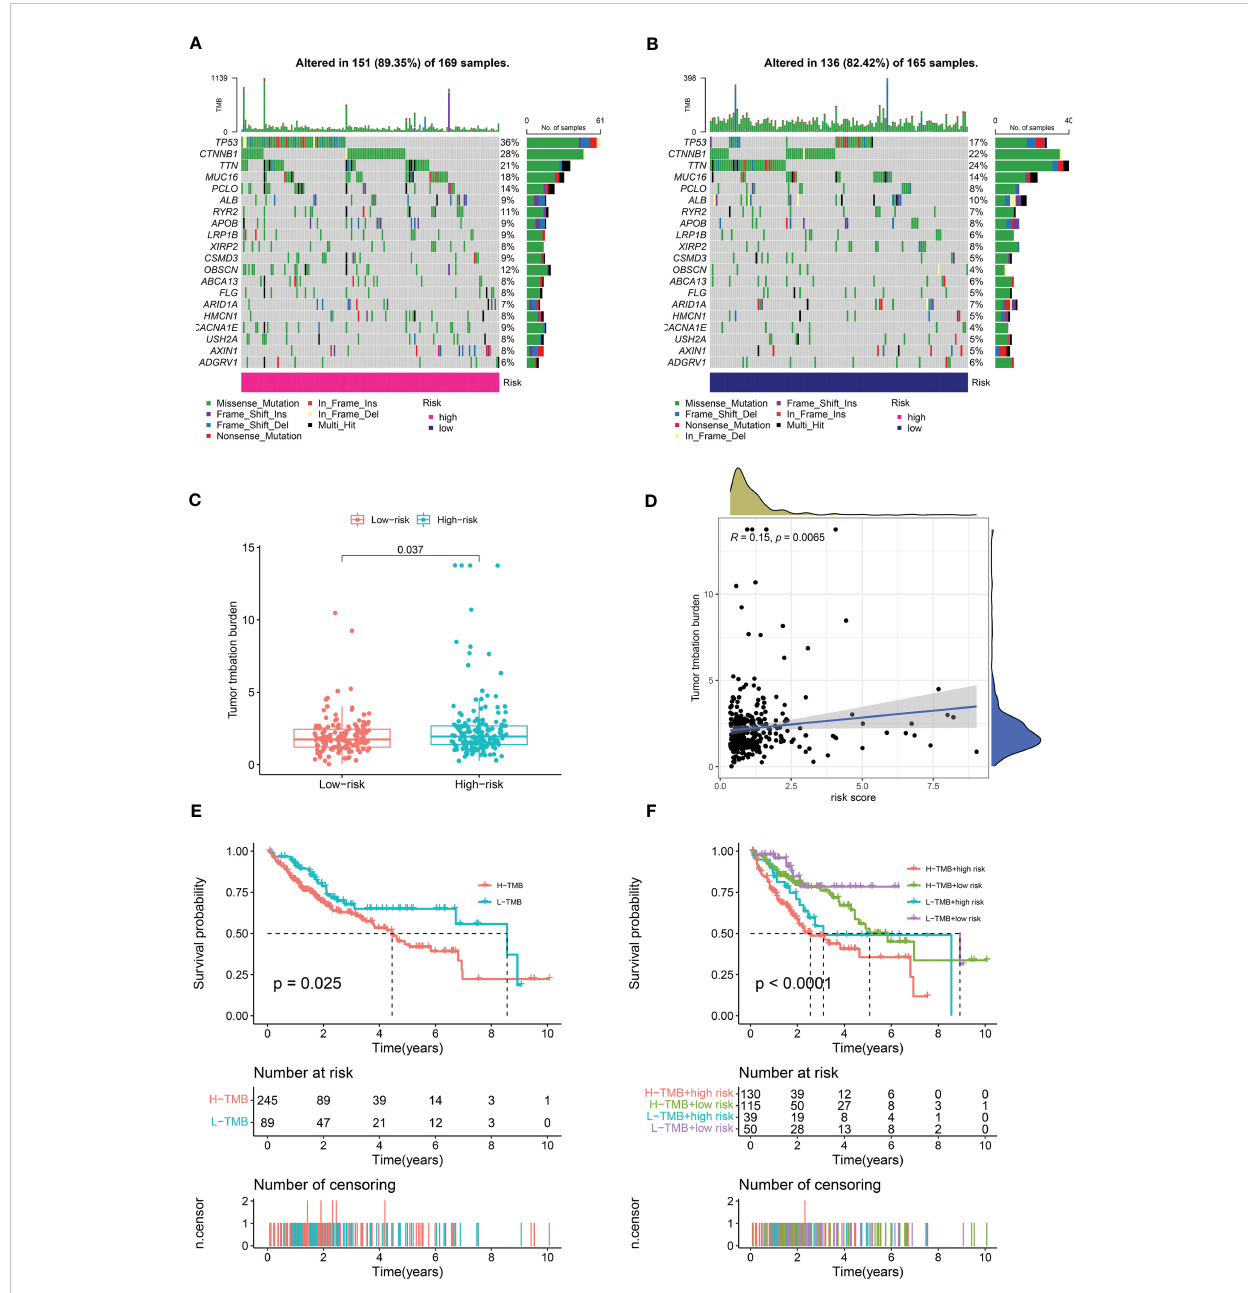
FIGURE 8 Tumor Mutational Burden and related analysis. Waterfall plots of mutated genes in (A) the high-risk group and (B) the low-risk group. (C) TMB difference in the high- and low-risk patients. (D) Correlation point plot for risk score and TMB. (E) Kaplan – Meier curve analysis of OS is shown for patients in high and low TMB. (F) Kaplan – Meier curve analysis of OS is shown for patients classi fi ed according to the TMB and cuproptosis-related lncRNA